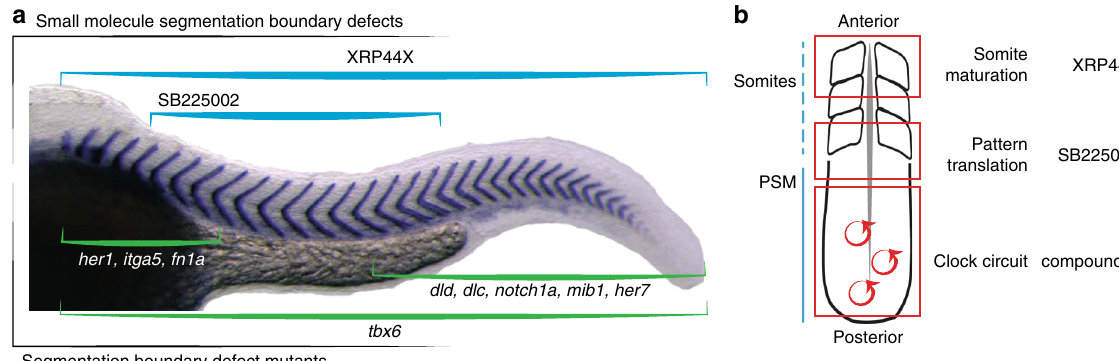
Fig. 7 Overview of selected direct segmentation phenotypes. a Schematic of axial distributions of known mutant somite boundary defects (green brackets) and newly identi fi ed small molecule perturbation defects (blue brackets, this paper). Her1 , integrin α 5 [ itga5 ] and fi bronectin 1a [ fn1a ] anterior defects; T-box 6 [ tbx6 ] mutants, defects along axis; mutants deltaD [ dld ], deltaC [ dlc ], notch1a , mindbomb E3 ubiquitin protein ligase 1 [ mib1 ] and her7 , posterior defects 11,12,71 – 74 . b Schematic highlighting steps of segmentation (clock circuit, pattern translation, somite maturation) in red boxes and examples of small molecules from the screen that affect the